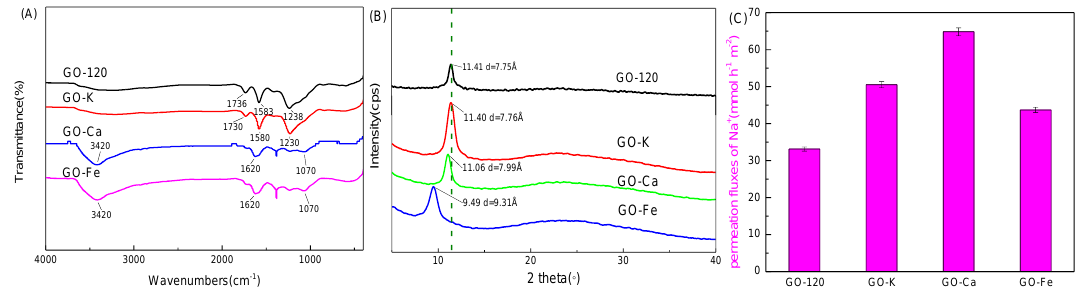
Figure 6. FTIR spectra ( A ) and XRD patterns ( B ) of GO-120, GO-K, GO-Ca, GO-Fe; Permeability of Na + through GO-120, GO-K, GO-Ca, and GO-Fe ( C ). (C) 0.02 mol / L NaNO 3 solution in feed tank, 1.0 mol / L HNO 3 in permeate tank; t = 12 h.